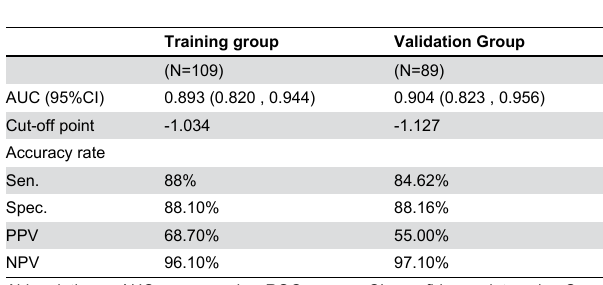
Table 6. Summary of validity of APPCI model in the training and validation